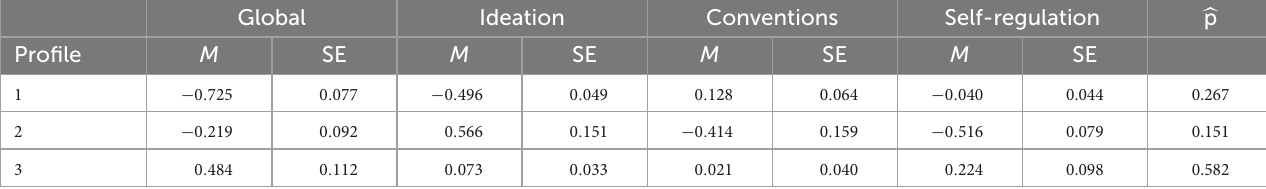
TABLE 6 Profile indicator means and standard errors